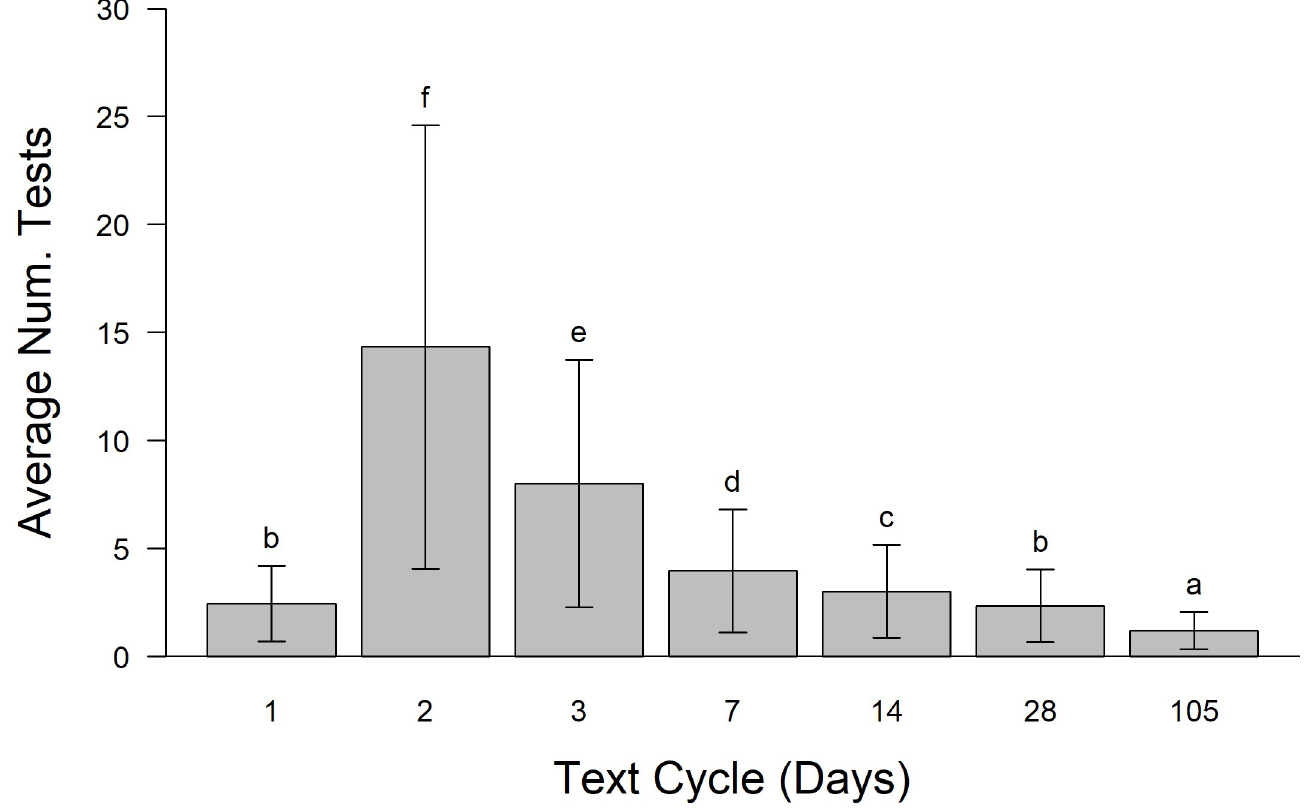
Fig 9. The average number of tests conducted per person versus testing cycle. These simulations include only tests with contact tracing and no masking using the college networks. The average number of tests per person was greatest when individuals were tested every other day. This was far greater than when individuals were tested daily because individuals that tested positive were isolated, not tested during this period and most effectively curtailed the outbreak. Error bars are ± 95% confidence intervals. Samples sharing letters are not statistically